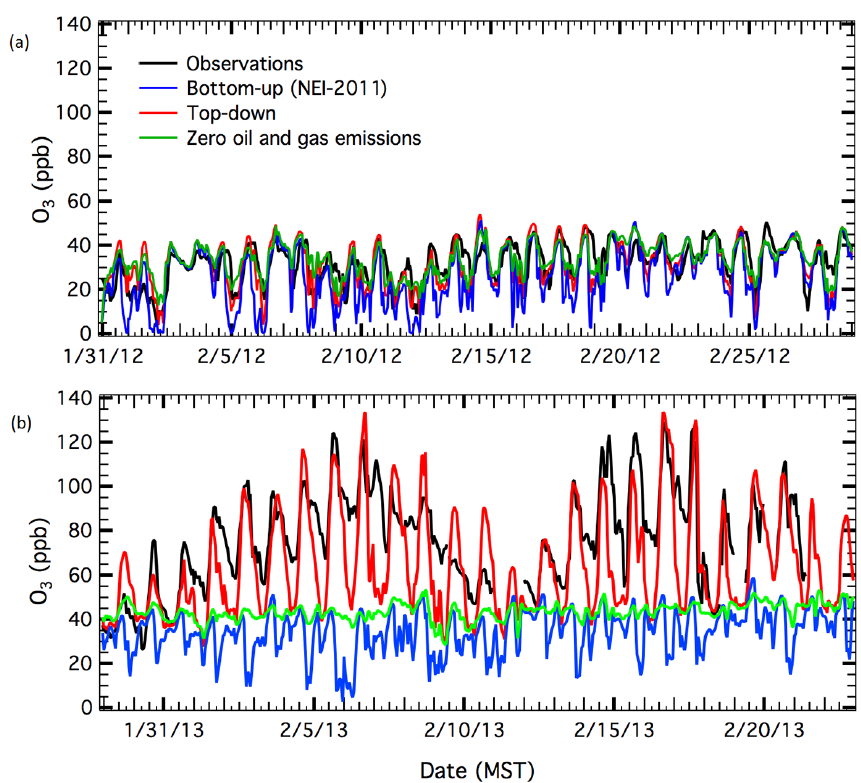
Figure 3. Time series of the measured and modeled hourly O 3 mixing ratios at Horse Pool in (a) 2012 and (b)